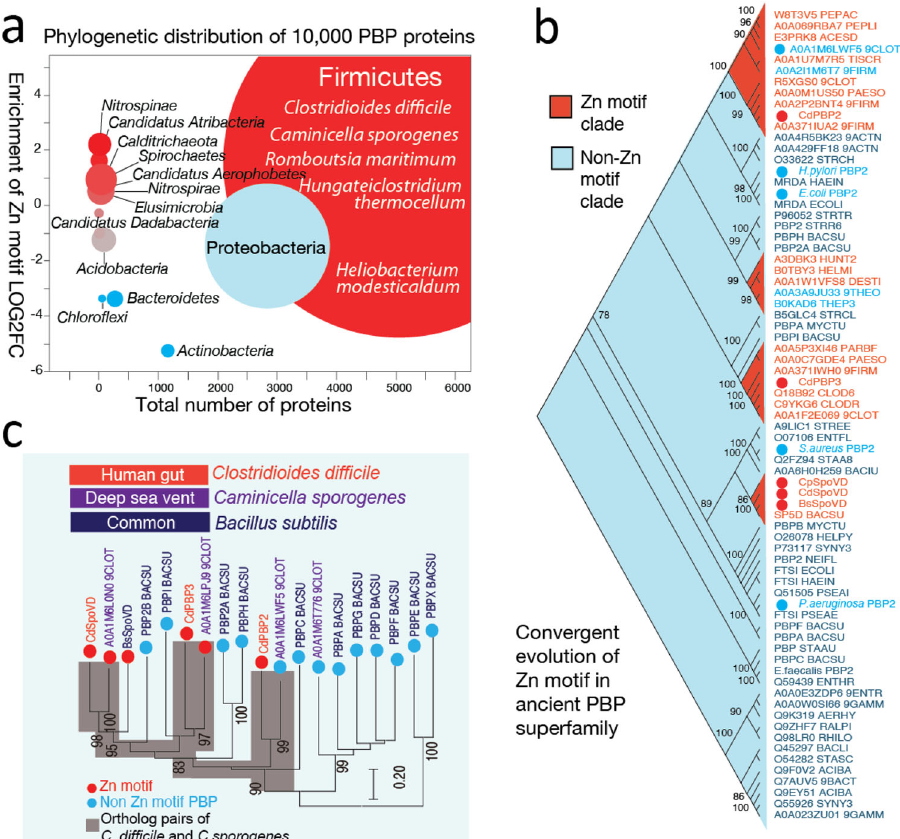
Fig. 5 | Phylogenetic distributions and evolutionary patterns of Zn 2+ -binding motifsinthePBPsuperfamily. RedindicatesenrichmentofZn 2+ -bindingPBP,blue indicatesabsenceofZn 2+ -bindingPBPs. a Over10,000PBPswereanalyzedandZn 2+ - binding motifs were identi fi ed with a custom-built hidden Markov model (HMM). Circle size represents the number of species. Representative species are listed for Firmicutes. b StructurallydiversePBPsuperfamilymembersfromdiversetaxawere